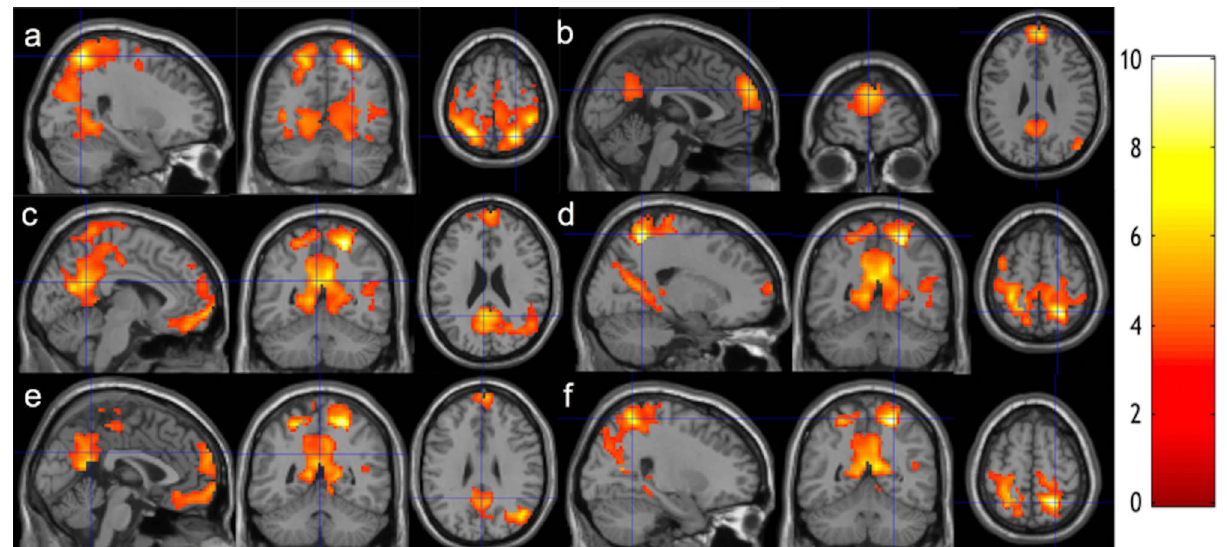
Figure 2. Increased functional connectivity from baseline to follow-up . Regions overlaid on a standard brain template in which significantly increased functional connectivity was observed with a seed ROI at the (a) PCC, (b) RMT, (c,d) RSPL, (e,f) LSPL regions after 2-month meditation training at the thresholds of a voxel-level p-value of 0.01 and corrected cluster-level p-value of 0.05. The color bar shows the range of t-values. PCC posterior cingulate cortex, RMT right medial temporal cortex, RSPL right superior parietal lobule, LSPL left superior parietal